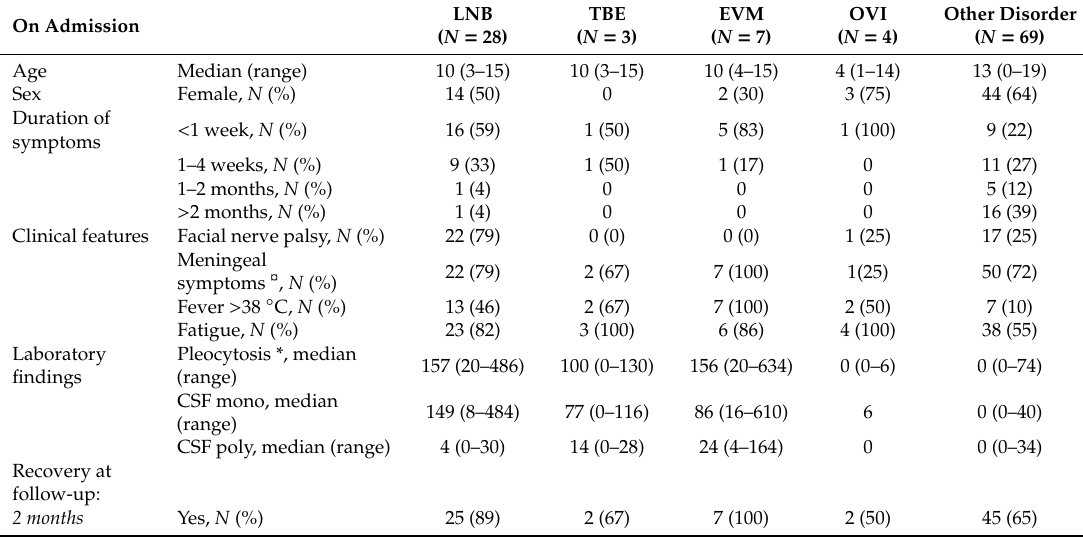
Table 1. Characteristics of paediatric